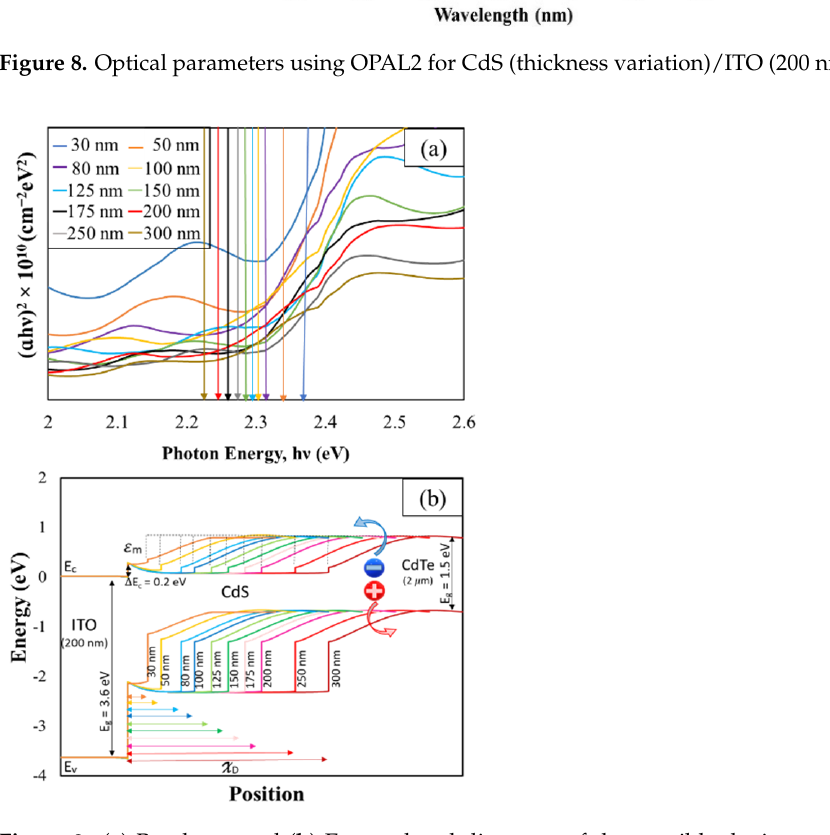
Figure 8. Optical parameters using OPAL2 for CdS (thickness variation)/ITO (200 nm)/UTG.